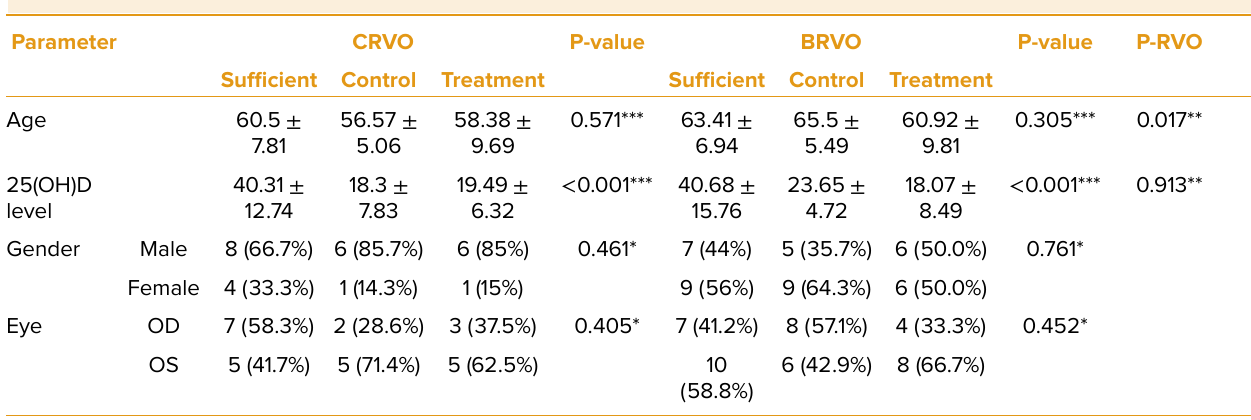
Table 1. Characteristics of studied